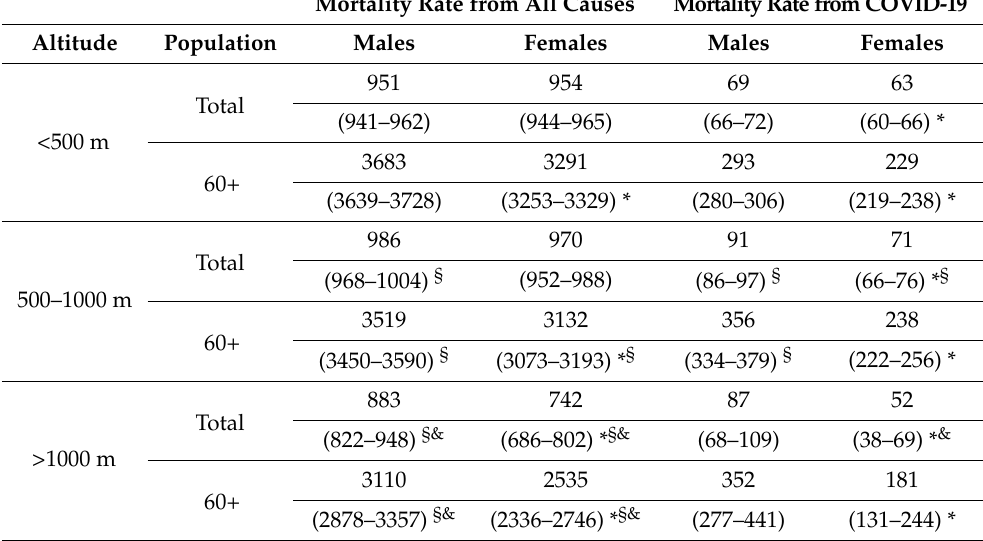
Table 2. Altitude-dependent mortality rates for both sexes of the overall population and those aged 60+ (per 100,000 of the respective population; and 95% confidence intervals) from all causes and from COVID-19 in